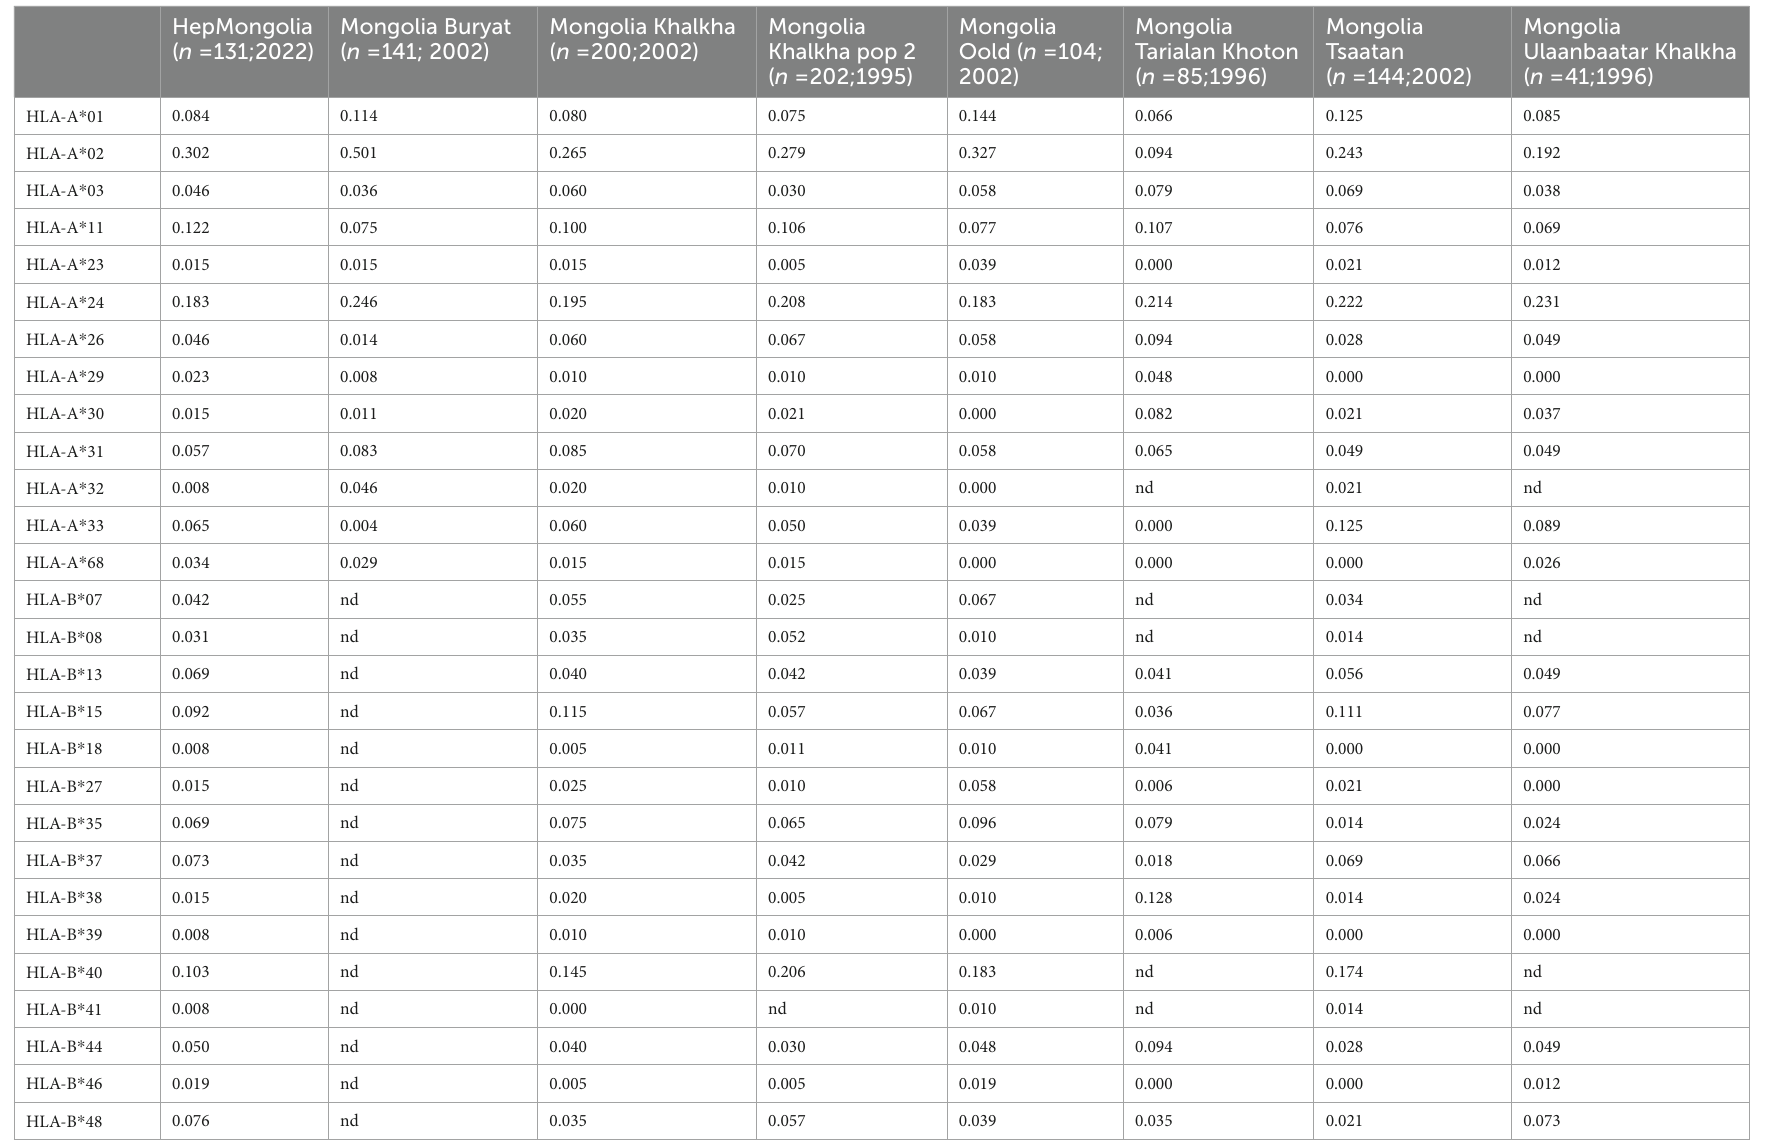
TABLE 2 Comparison of the HLA polymorphism of the Mongolian population. HepMongolia Mongolia Buryat Mongolia Khalkha ( n = 131;2022) ( n = 141; 2002) ( n =